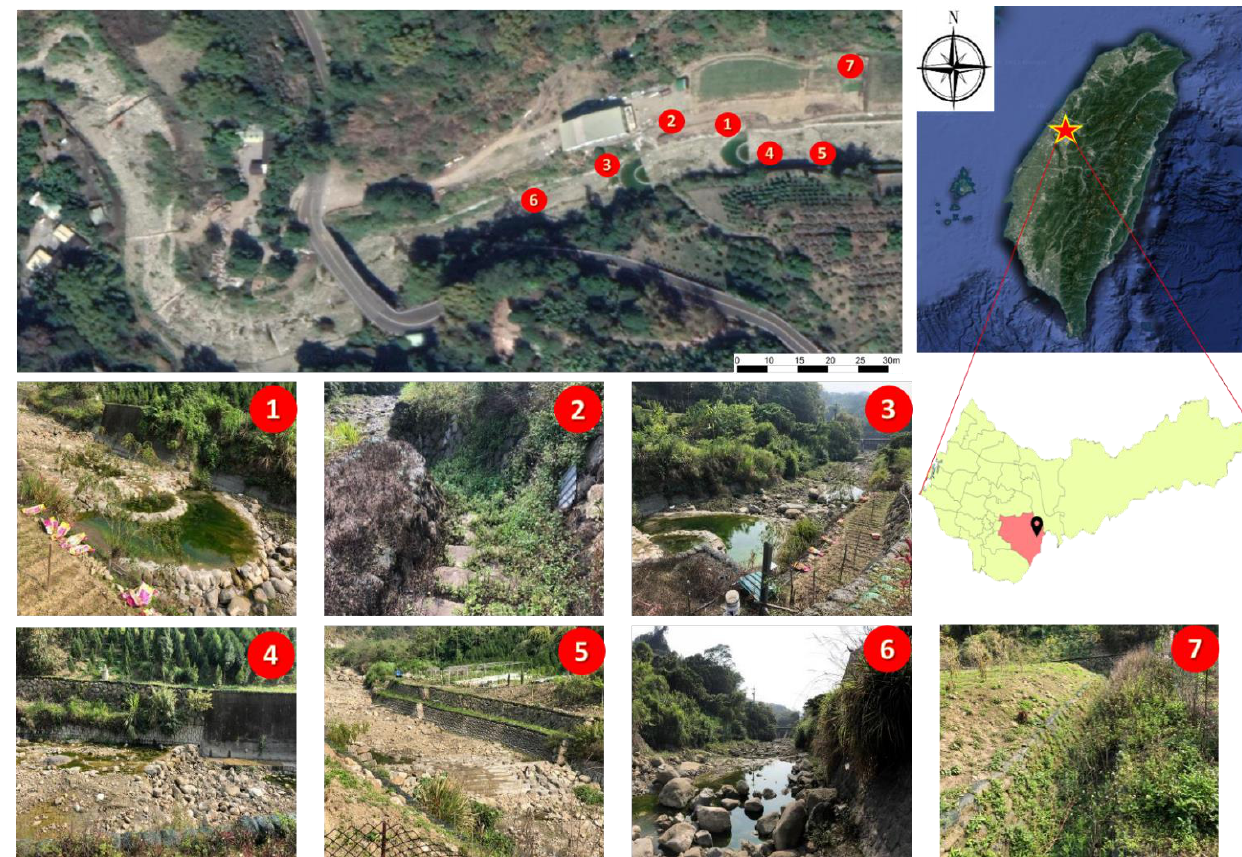
Figure 2. On-site survey picture of the “Upstream Renovation Project of Toubiankeng Stream